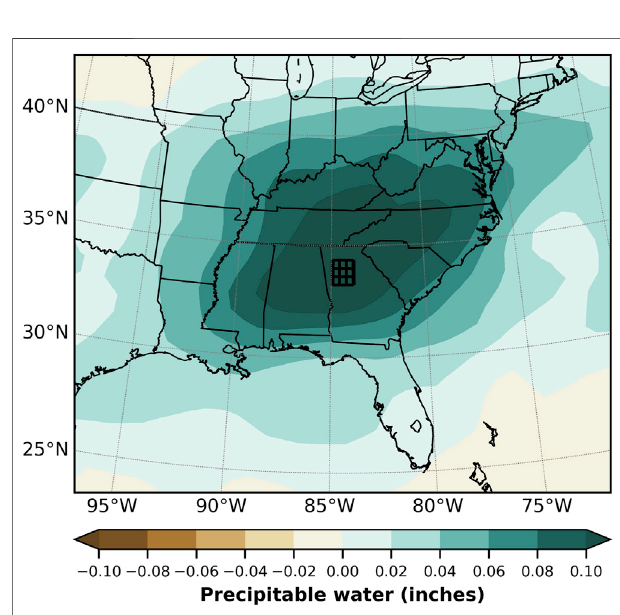
FIGURE 7 | Composite anomaly map of precipitable water for URDs compared to non-URDs. The 9-cell gridded framework centered on Atlanta is indicated by the black-outlined